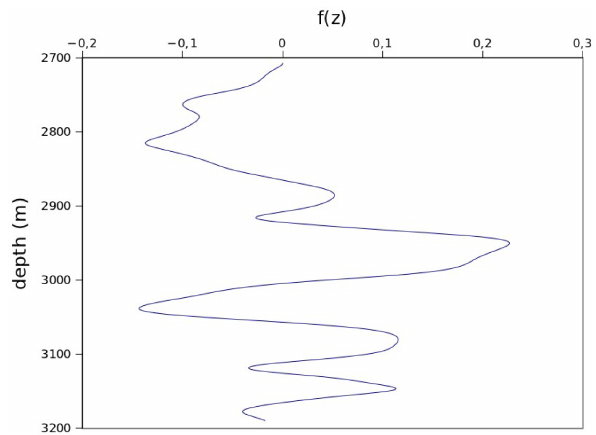
Fig. 2. Evolution of the error in the logarithm of thinning function as a function of the depth in the EDC ice